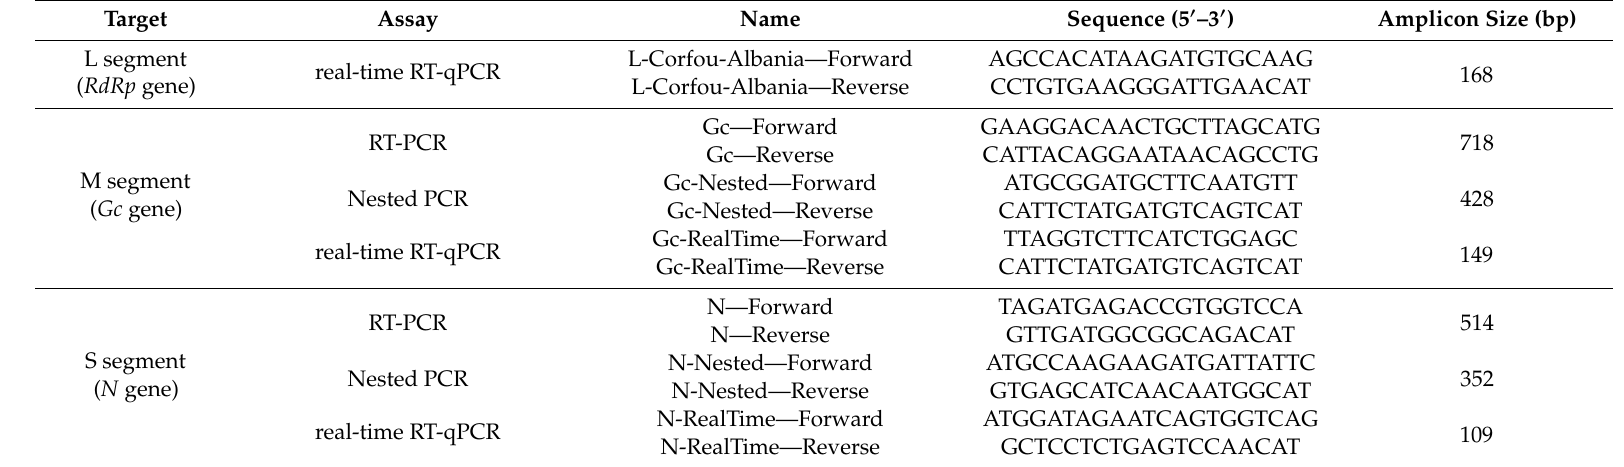
Table 1. Corfou (CFUV) virus specific